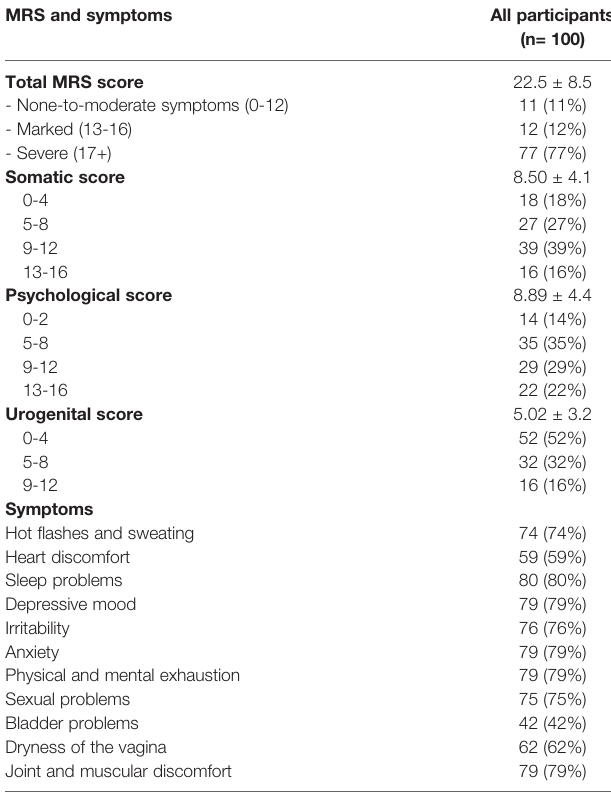
TABLE 1 | Demographic, anthropometric and medical data, lifestyle habits, adherence to the Mediterranean diet, and sleep quality of all study participants. Parameters